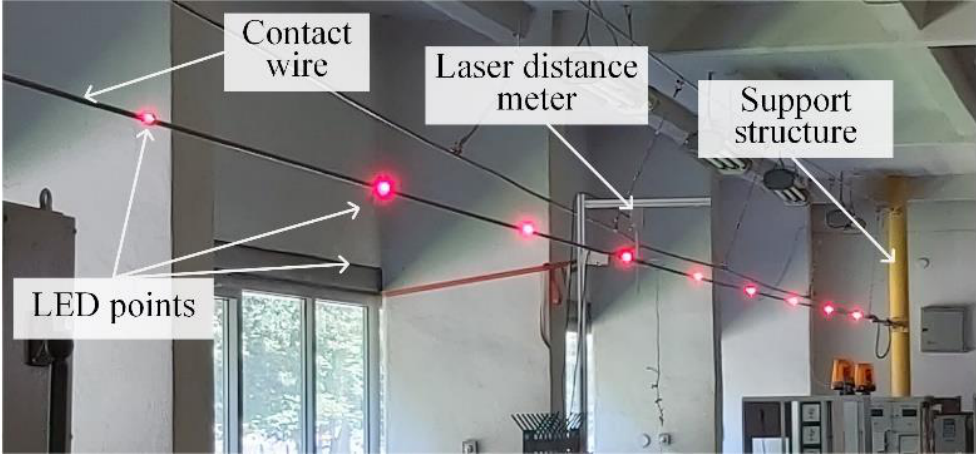
Figure 8. Scheme of the test stand, where P 1 , … P 9 – light points.